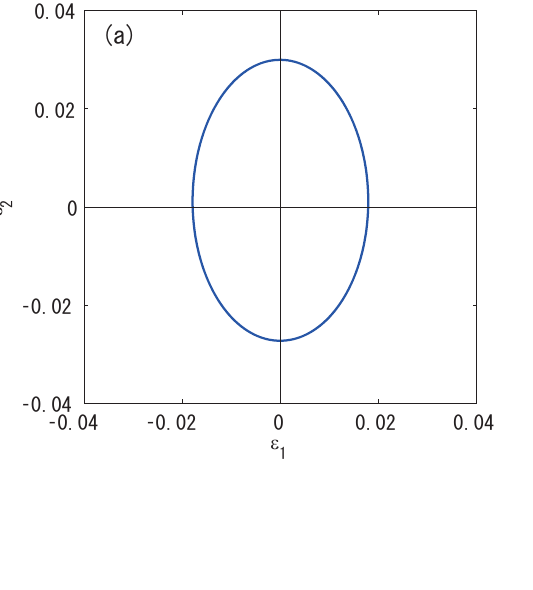
Figure 7. Example of an asymmetric ellipse obtained by setting p ( a ), and the definitions of the angle θ